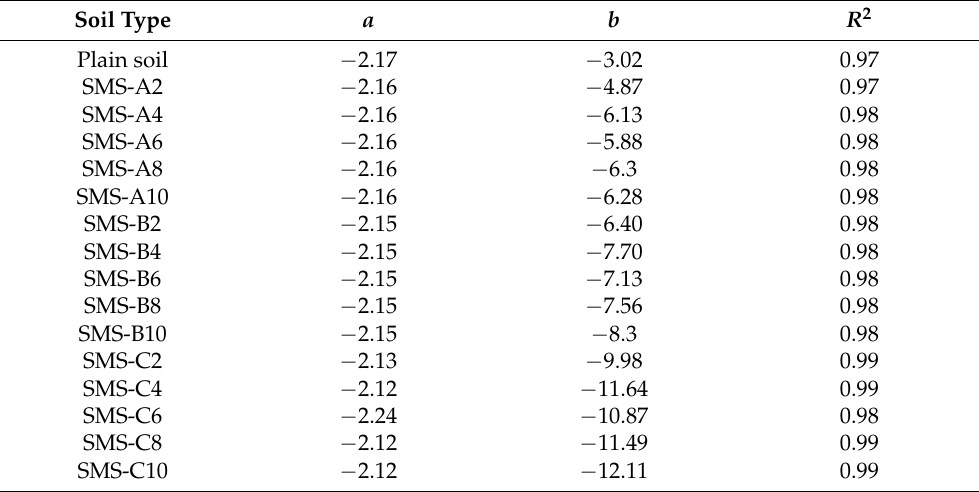
Table 5. Parameters of fitting curves of unsaturated permeability coefficients after different hydropho- bic